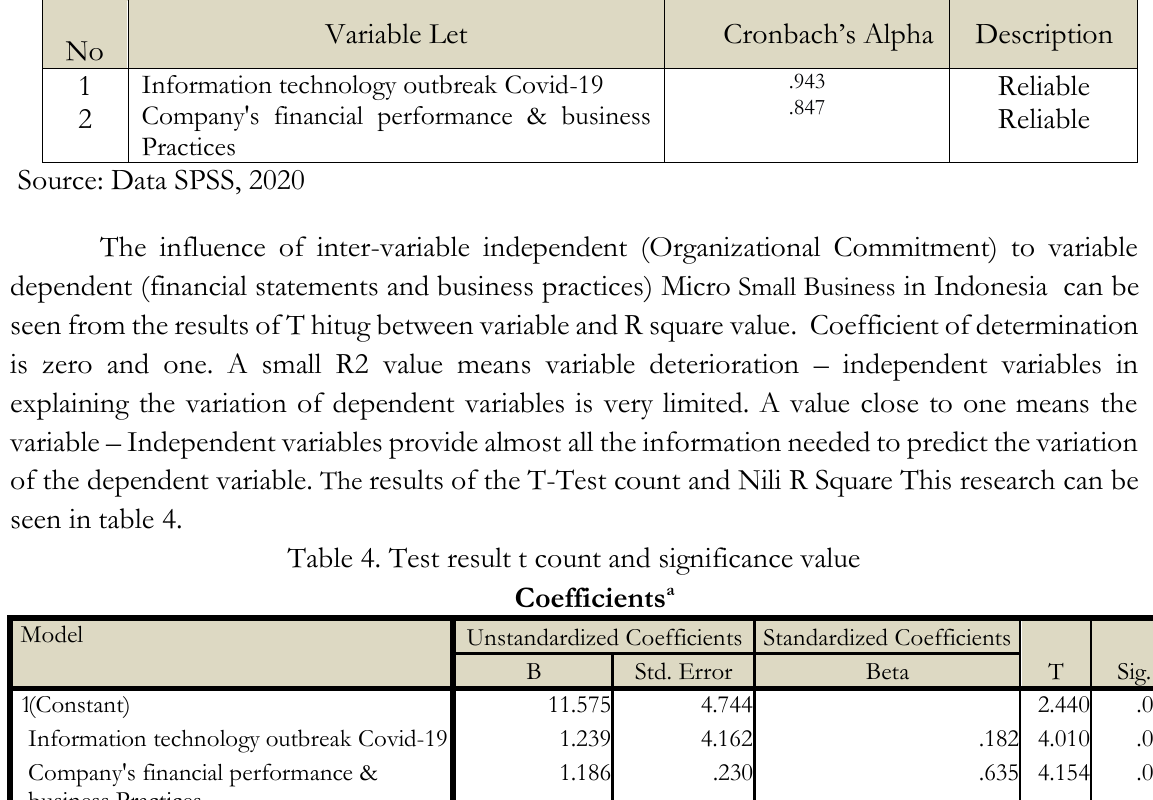
Table 3. Reliability test Results